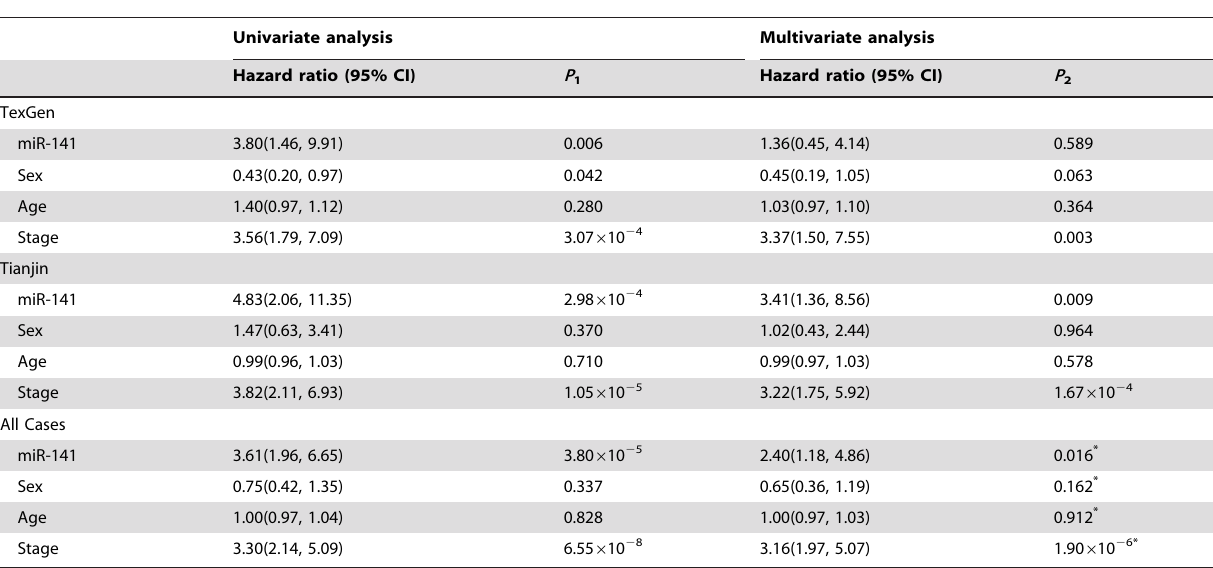
Table 1. Plasma miR-141 is an independent prognostic factor by Cox regression analysis.